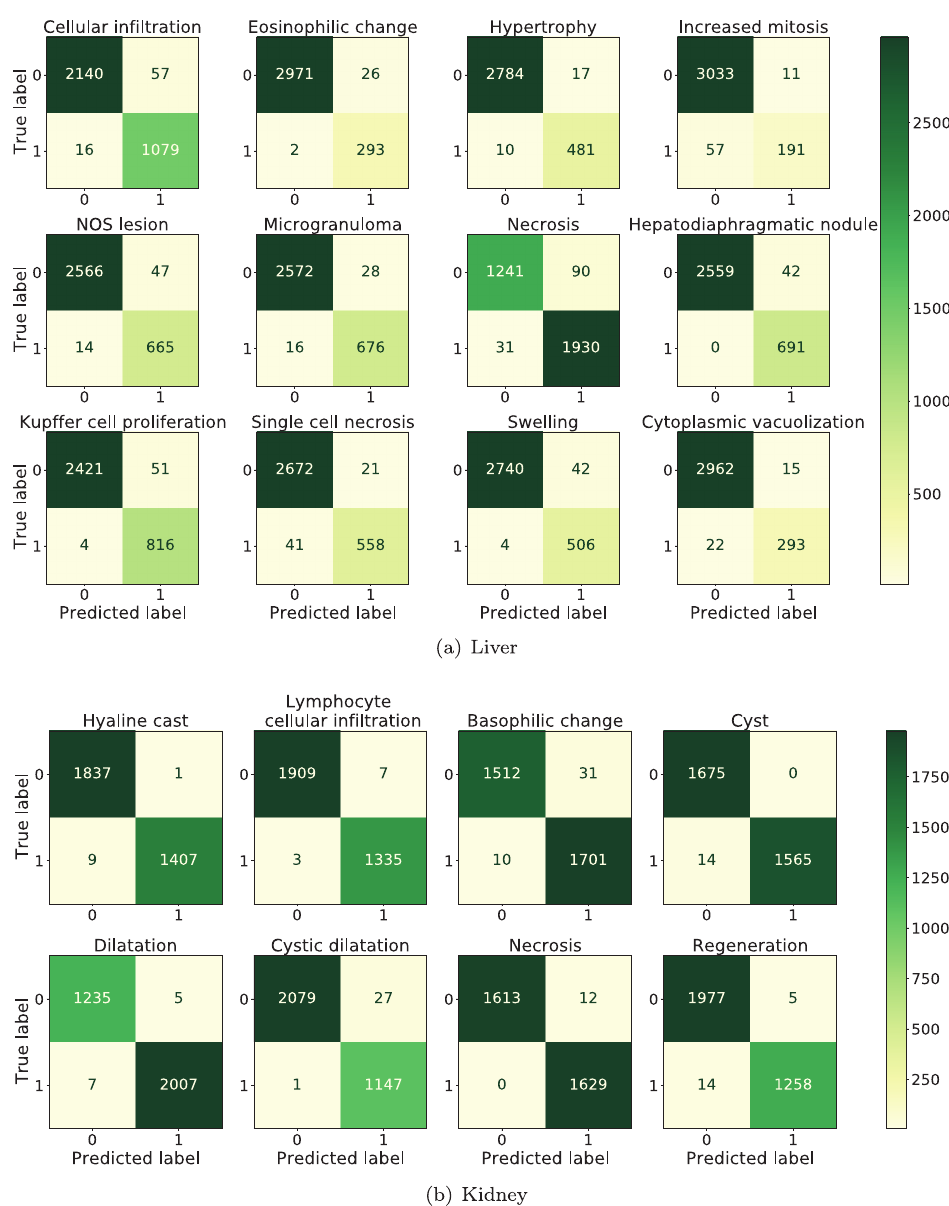
Fig 4. The confusion matrix of the pathology classification. The top-left represents the TN, the top-right represents FP, the bottom-left is FN and the bottom-right is TP. (a) shows the confusion matrix on liver data and (b) shows the confusion matrix on kidney data. The results were obtained from the first fold. The results of other folds are shown in S3